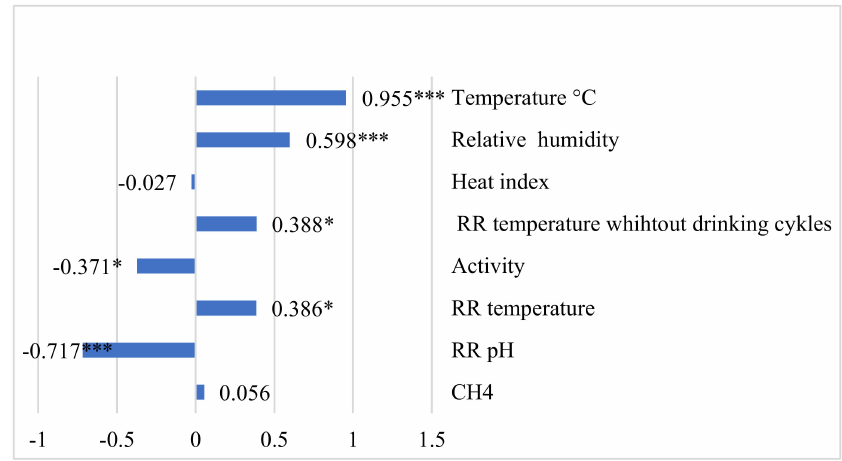
Figure 3. Correlation coefficients between THI, methane, and reticulorumen indicators. * p < 0.05, *** p < 0.001. CH 4 —methane; RR—reticulorumen.